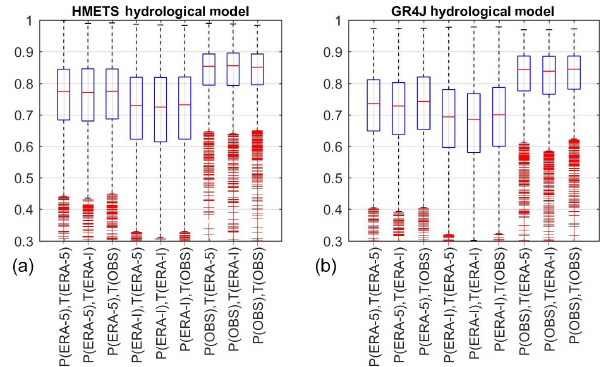
Figure 4. Distribution of calibration KGE scores for all water- sheds as a function of meteorological inputs for HMETS (a) and GR4JCN (b)